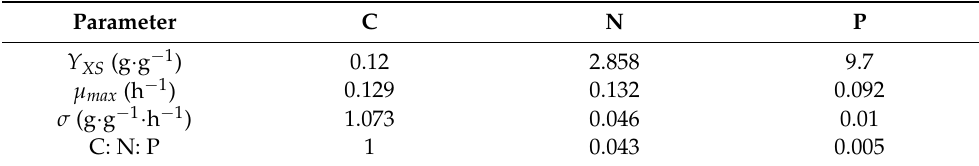
Table 2. K. marxianus cultivation process parameters obtained via micro-cultivations.